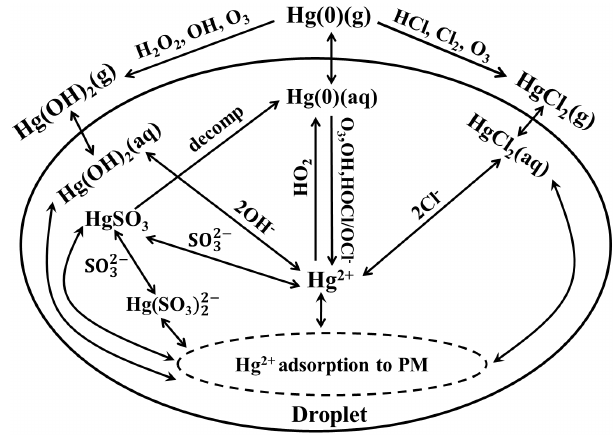
Figure 1. Schematic of different mercury reactions utilized in the GNAQPMS-Hg